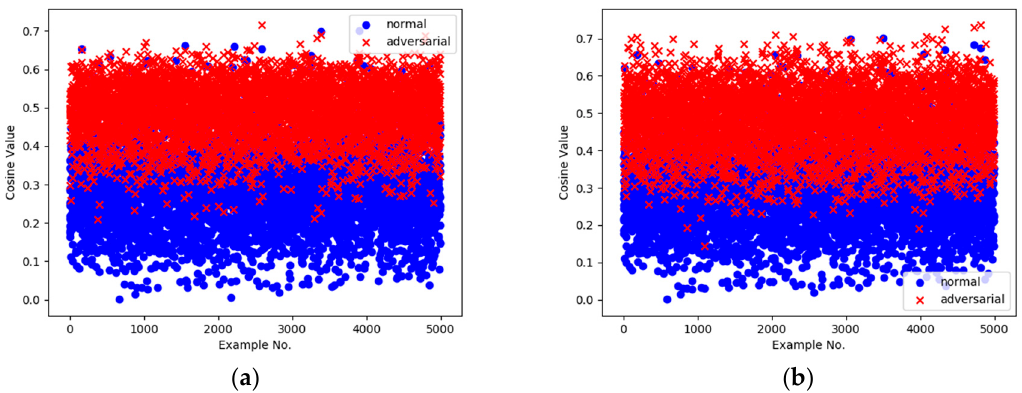
Figure 8. Scatter plot of fusion result of examples in the validation set. The x axis is the example number, and the y axis is the corresponding cosine value. ( a ) Adversary uses the same UAP as the one applied during the training phase; ( b ) Adversary uses the UAP generated on a different architecture.